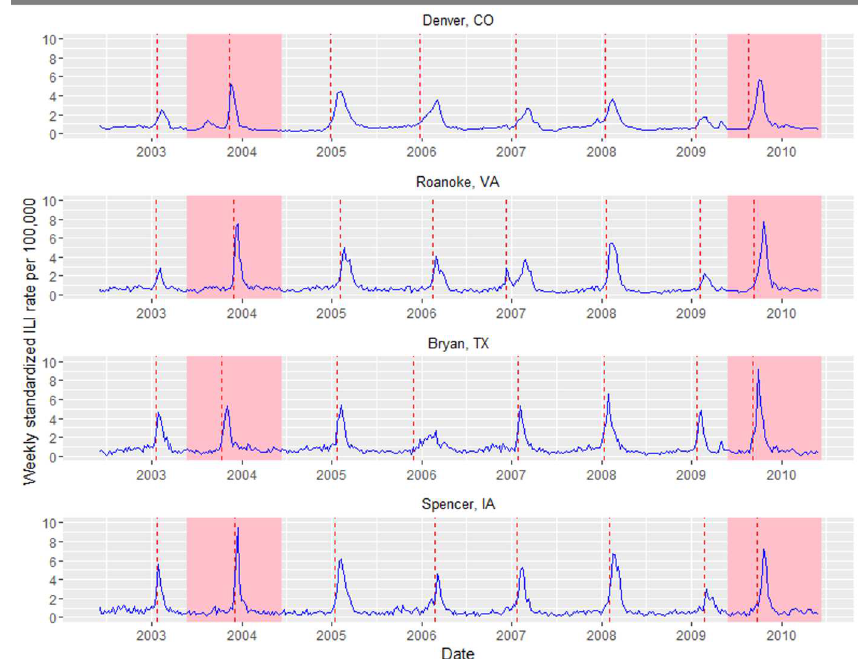
Fig 1. Standardized influenza-like-illness time series from four locations (Denver, CO; Roanoke, VA; Bryan, TX; Spencer, IA). Onset times for each season are depictedas red dashed lines. The 2003/2004 epidemic and 2009/2010 pandemicare highlighted in pink as these are major influenzaseasons associated with antigenicnovelty, where more than 99% of viruses in circulationwere of the same subtype (A/H3N2 in 2003/2004 and A/H1N1 in 2009/2010). These major seasonshad the most distinct influenzasignals, while few locationsexperienced an increase in ILI during the mild 2008/2009epidemic dominated by the A/H1N1